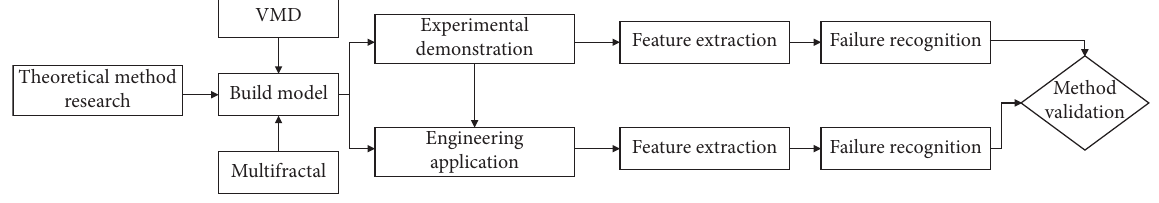
Figure 1: Research fow block